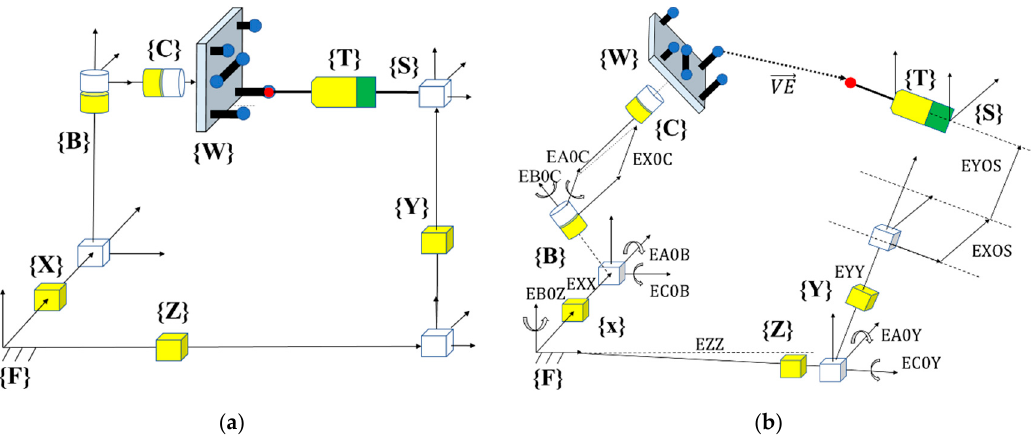
Figure 1. ( a ) Illustration of the nominal kinematic model of the target five-axis machine tool with WCBXFZYST topology; and ( b ) the real kinematic model of the machine tool with 10 axis alignment errors which lead to VEs in 3D space [24].